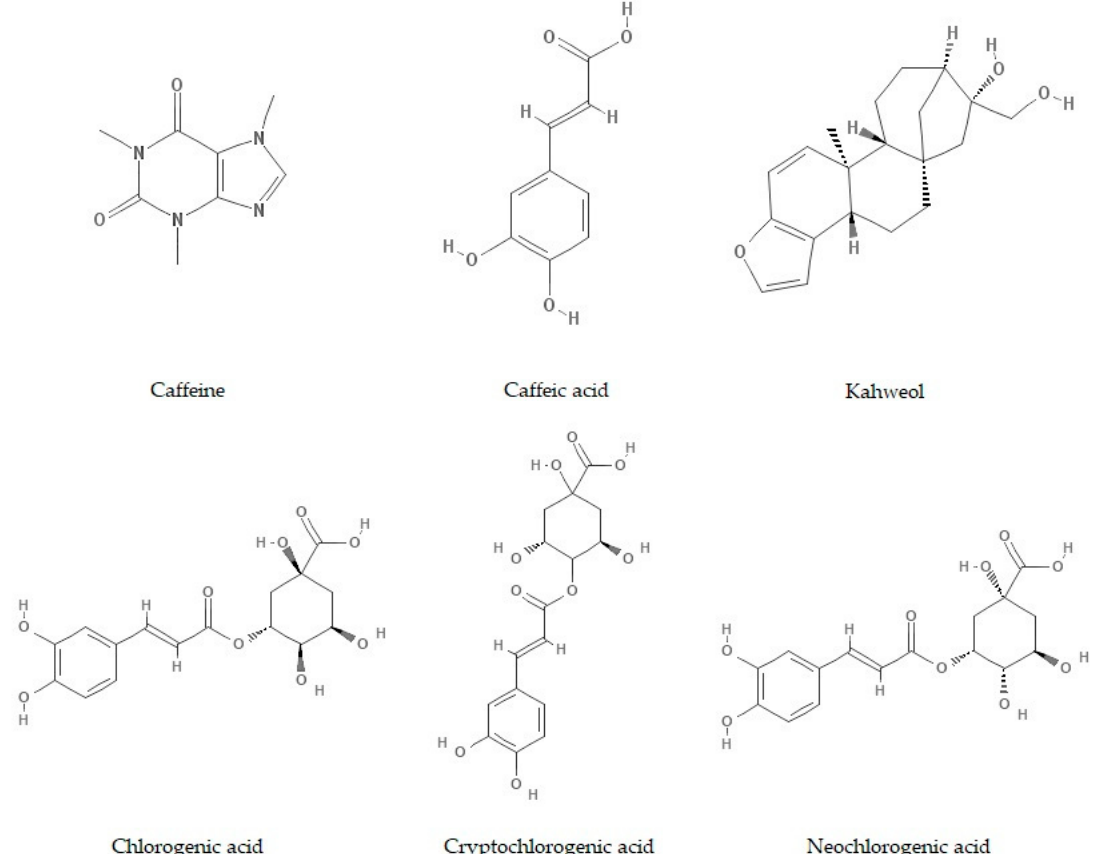
Figure 1. Chemical structure of caffeine, caffeic acid (CA), kahweol, and chlorogenic acids (CGAs) (adapted from Pubchem).